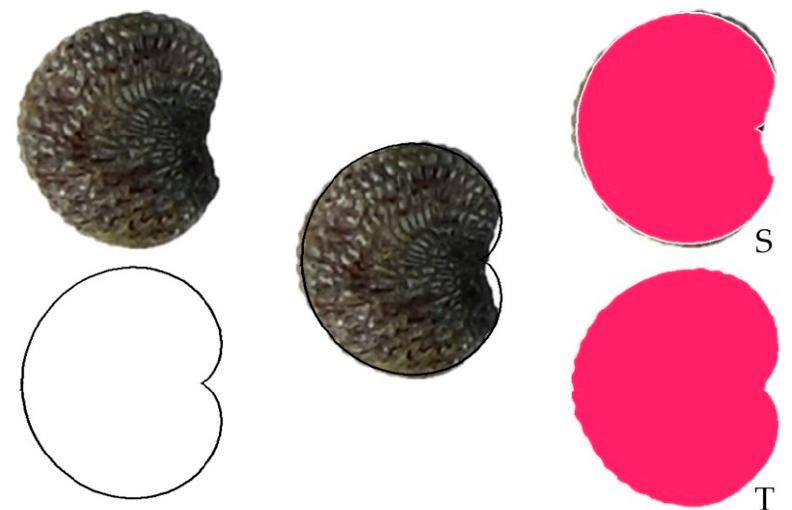
Figure 1. Left : Seed image (above) and geometric model (below). Center : The images of the seed and the model are superimposed. Right , in red: Shared area between the seed and the model (above) and total area (below). S = Shared area. T = Total area.